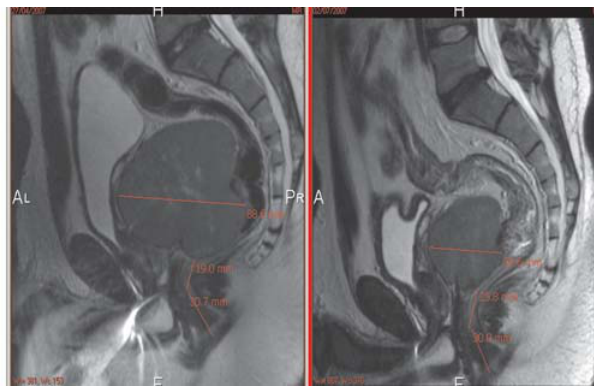
Figure1 - Pre- and post-treatment MRI (sagittal) illustrating the reduction in tumor size